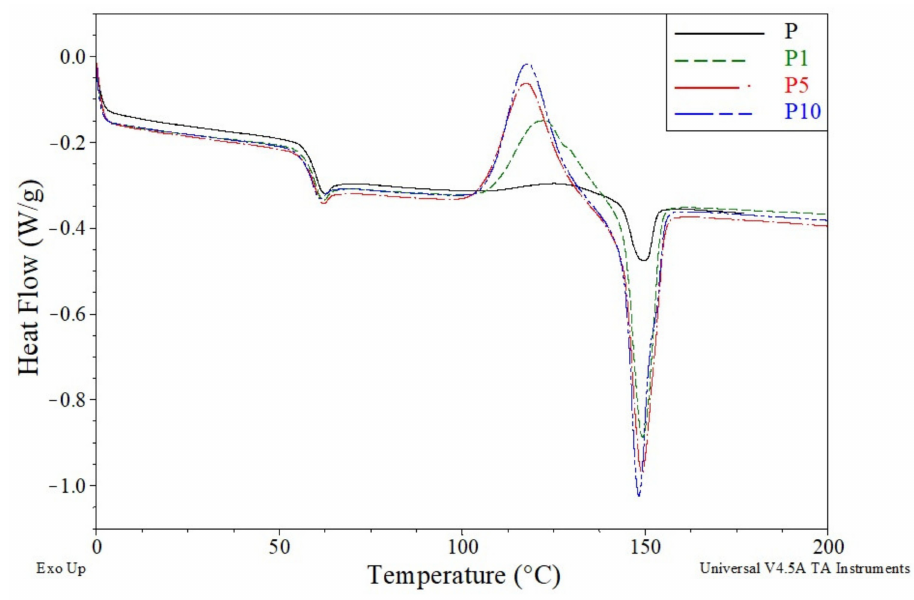
Figure 6. Differential scanning calorimetry (DSC) thermograms of samples P, P1, P5, and